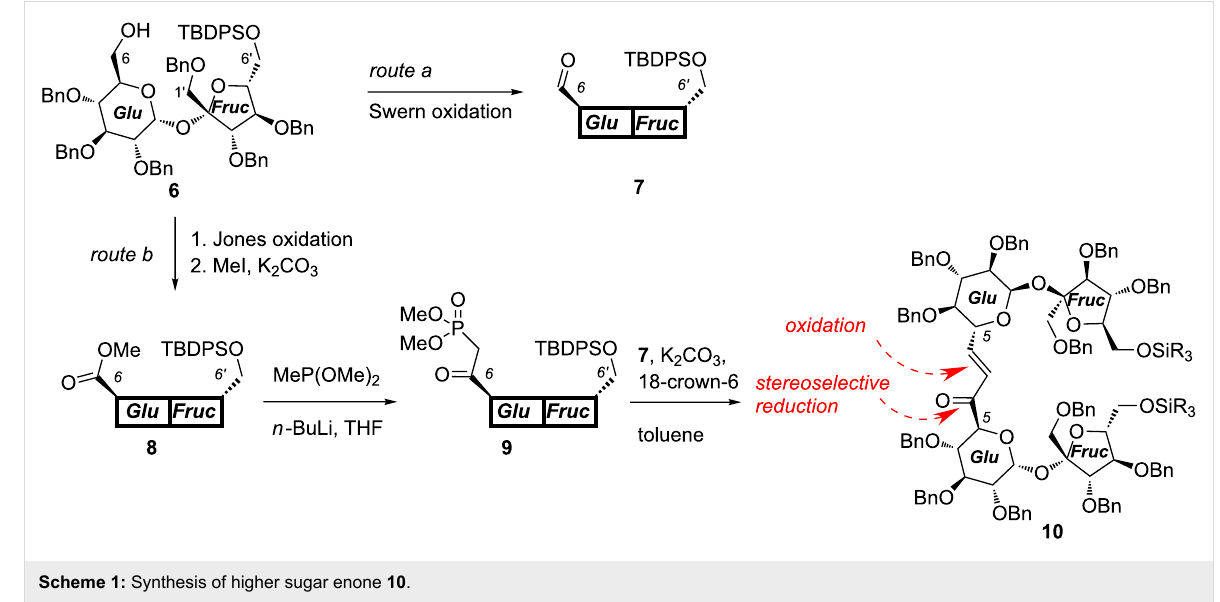
Scheme 1: Synthesis of higher sugar enone 10 .